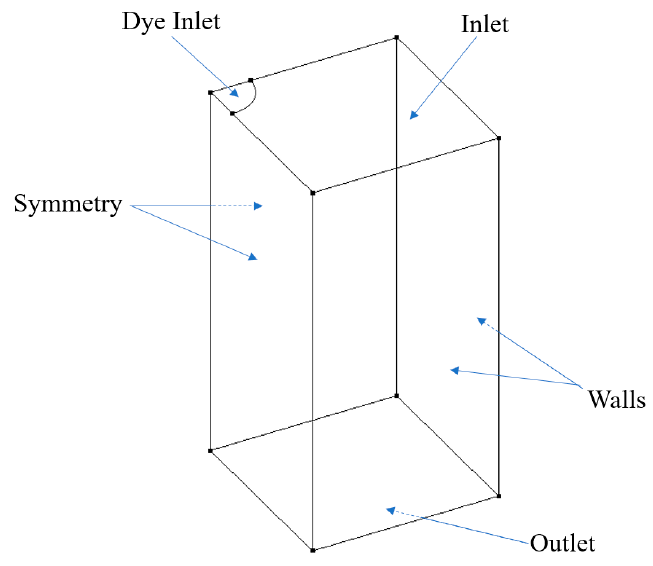
Figure 2. Schematic geometry for CFD simulations.